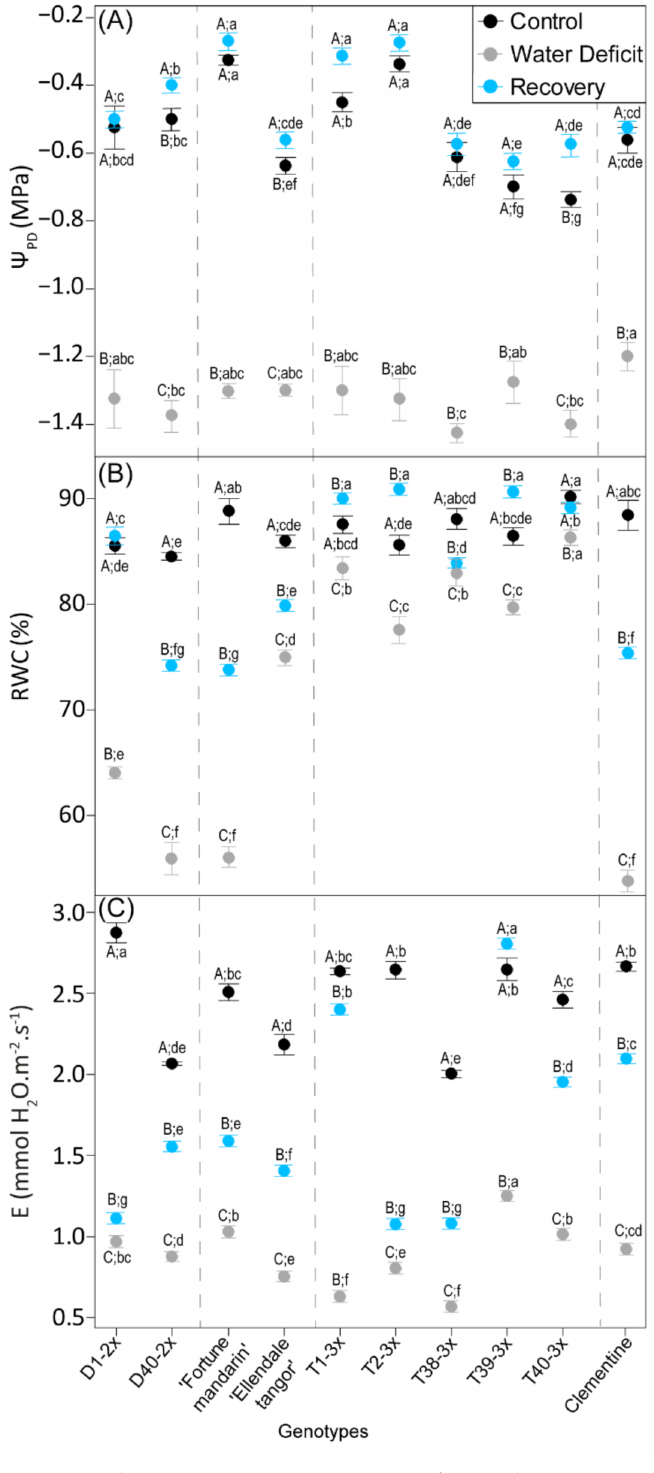
Figure 1. Plant water status parameters of 2x and 3x genotypes under three water treatments: 70–100% pot capacity (black point, control), 45–55% pot capacity (grey points, water deficit), and five days after re-watering (blue point, recovery). ( A ) Pre-dawn water potential ( Ψ PD ), ( B ) relative water content ( RWC ), and ( C ) transpiration rate ( E ). All data are mean values ( ± S.E.) of 3 independent measurements for Ψ PD ( n = 3) and 15 independent measurements for RWC and E ( n = 15). Data were analyzed with ANOVA and Fisher’s LSD test ( p < 0.05). Uppercase letters compare water treatments for each genotype. Lowercase letters compare genotype within the same water